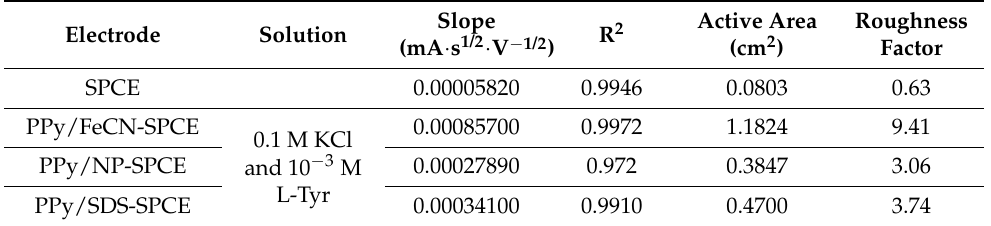
Table 4. Active area surface and roughness factor for the electrodes used in the analysis before and after